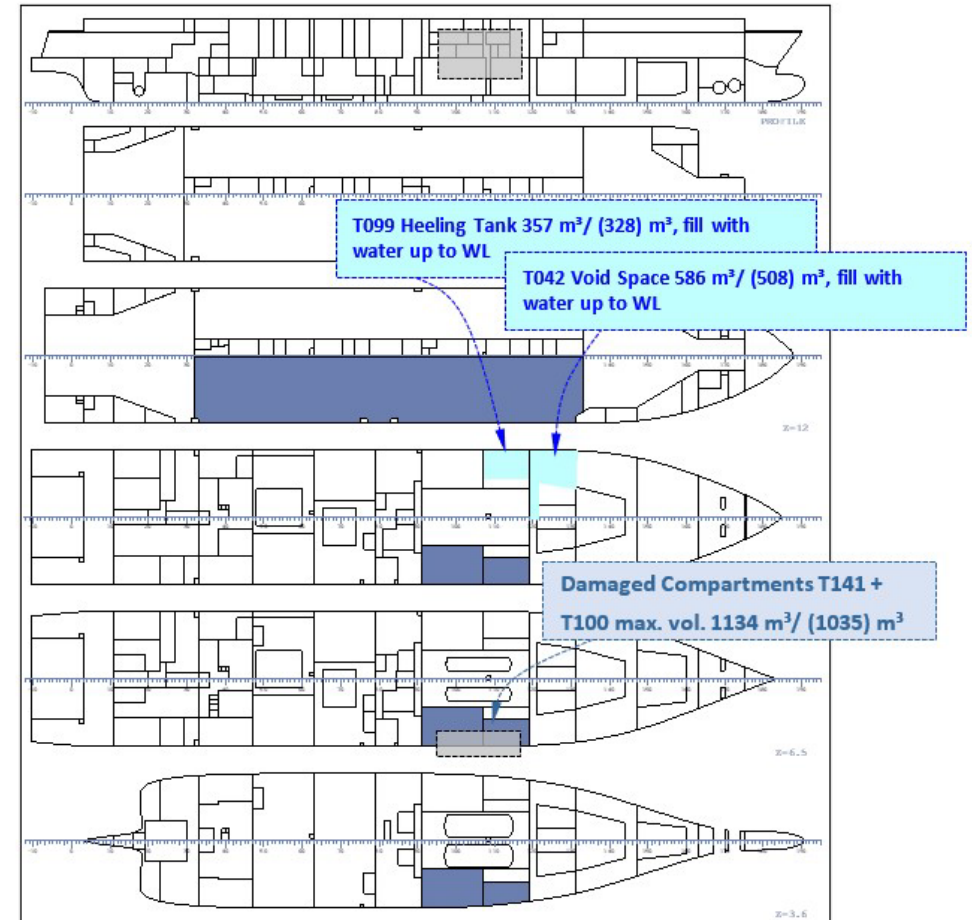
Figure 5. Damage Case 2 with counter flooding: The grey rectangle shows the damage penetration. The damaged compartments are shown with dark blue-grey, and the compartments for counter flooding with light blue. The first water volume values are those in the numerical model, and the values in brackets are the values realized in the scale model used in the model tests.